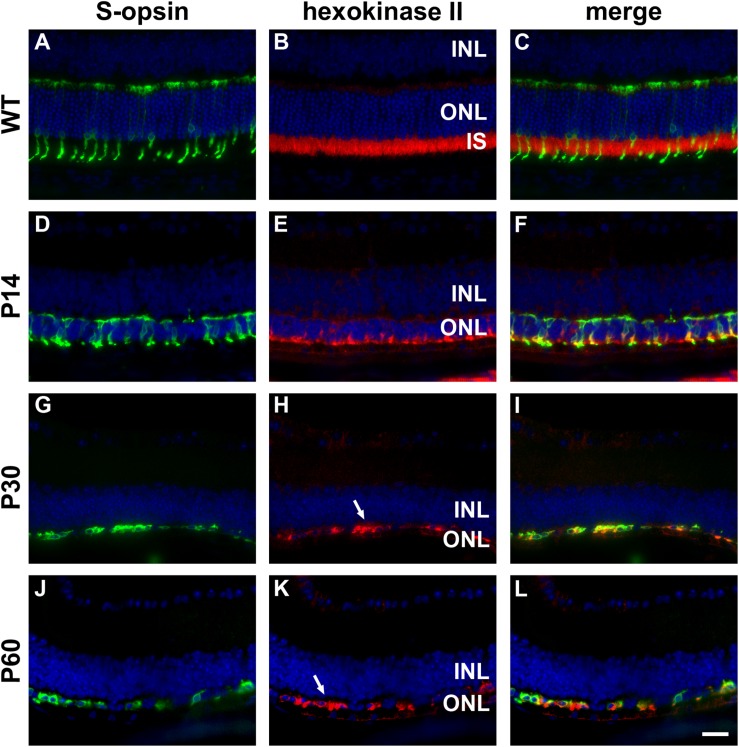
Representative double labeling immunofluorescence images of hexokinase II with S-opsin in wild-type (WT) mouse retina and in Rd1 mouse retinas from postnatal day (P) 14 to P60. (A–C) In WT retinas, hexokinase II is essentially restricted to rod and cone photoreceptor inner segments. (D–F) At P14, hexokinase II colocalizes with S-opsin in shrunken inner segments (arrow) and weakly labels occasional cone somas. (G–L) From P30 to P60, the ONL comprises a single layer of surviving cones largely devoid of segments. Hexokinase II colocalizes with S-opsin in cone somas (arrows). All images were captured from the inferior retina, which comprises primarily S-cones. INL, inner nuclear layer; IS, inner segments, ONL, outer nuclear layer; RPE, retinal pigment epithelium. Scale bar: 20 μm.